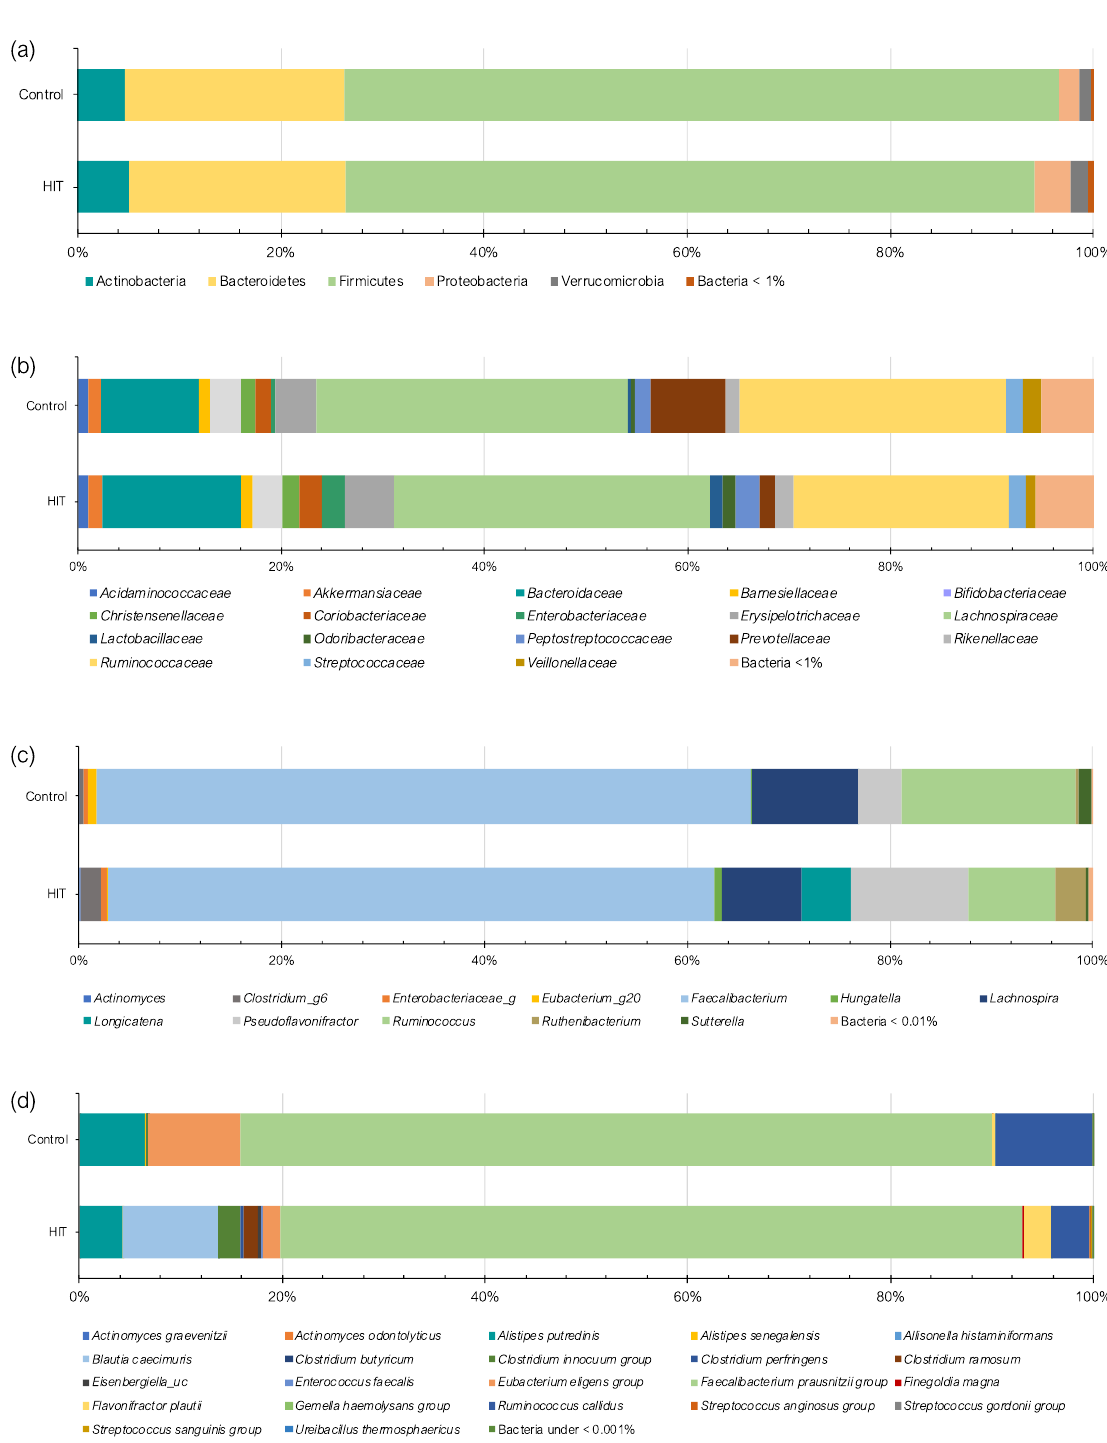
Figure 1. Relative abundance (%) of bacteria at the level of ( a ) phylum, ( b ) family, ( c ) genus and ( d ) species in control and histamine intolerance (HIT) groups. The genera and species are only represented if differences between the study groups were significant.